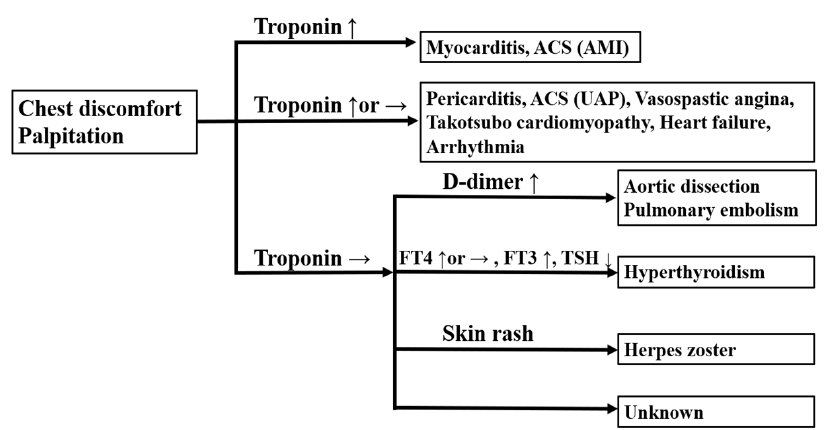
Figure 2. A flowchart of the differential diagnoses of chest discomfort and palpitation after COVID-19 vaccination. ACS: acute coronary syndrome; AMI: acute myocardial infarction; UAP: unstable angina pectoris; FT4: free thyroxine; FT3: free triiodothyronine; TSH: thyroid-stimulating hormone.